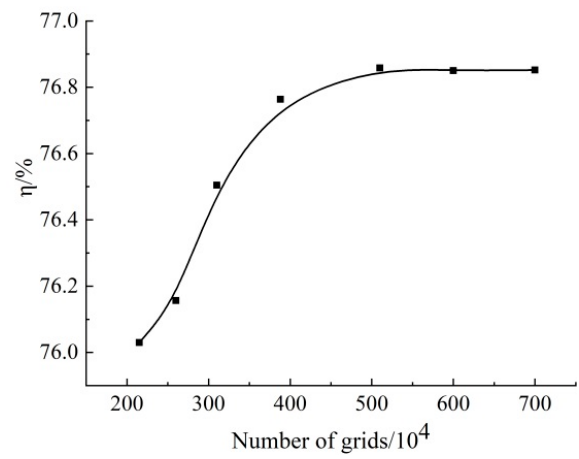
Figure 5. Influence curve of grid number on pump efficiency.